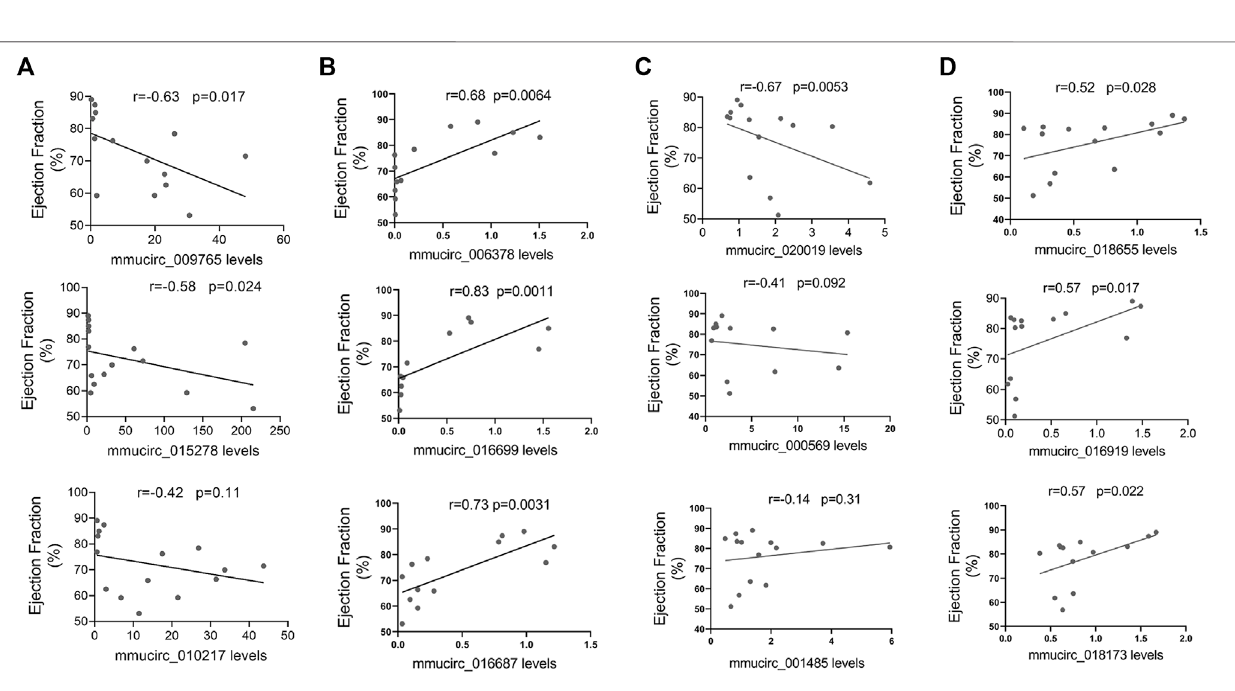
Frontiers in Cell and Developmental Biology |